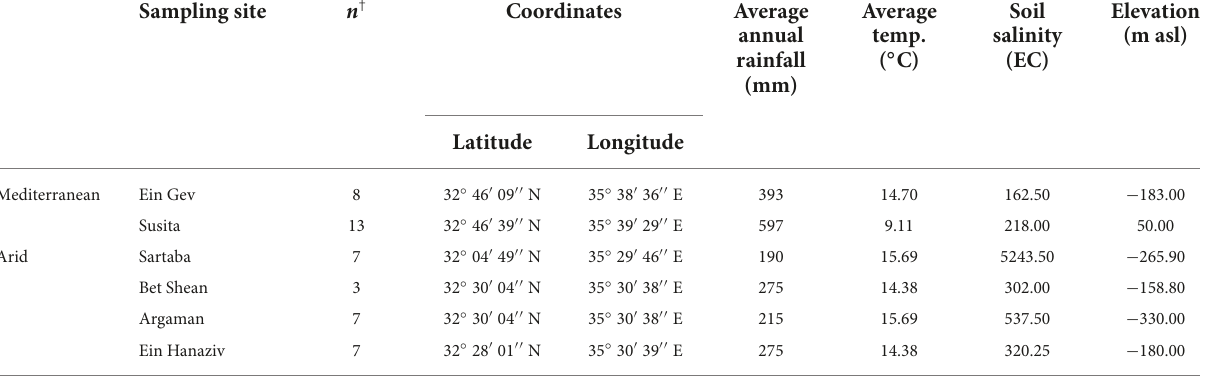
TABLE 1 The investigated populations of E. sativa , their location, and environmental characteristics. Sampling